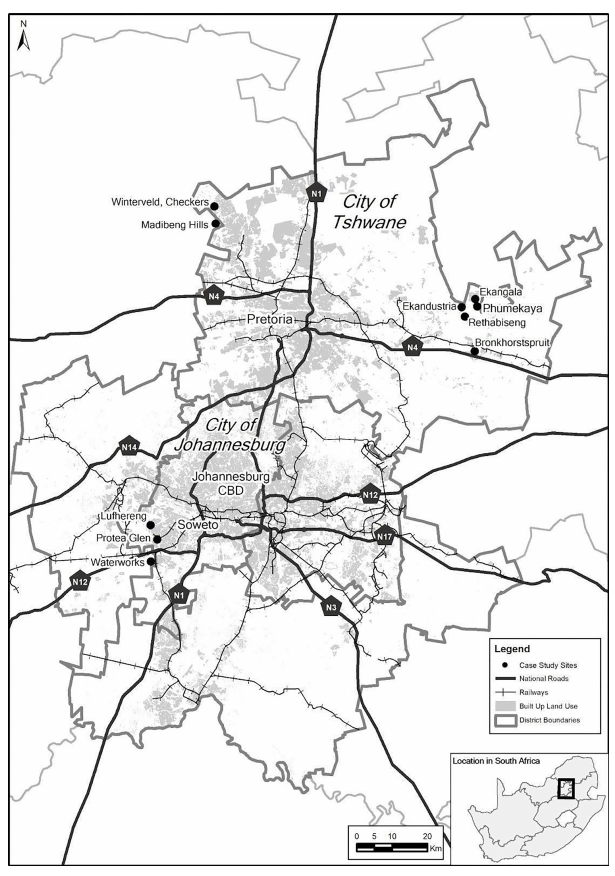
Figure 1. Location map of